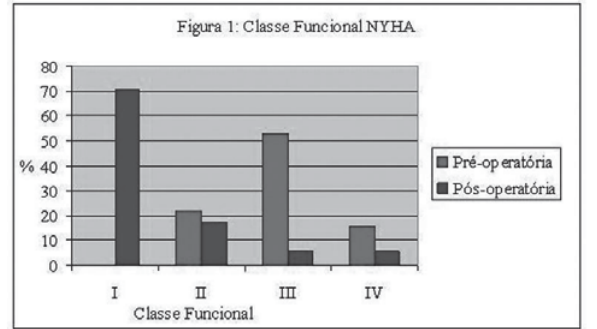
Fig. 1 - Análise da classe funcional pré e pós-operatória